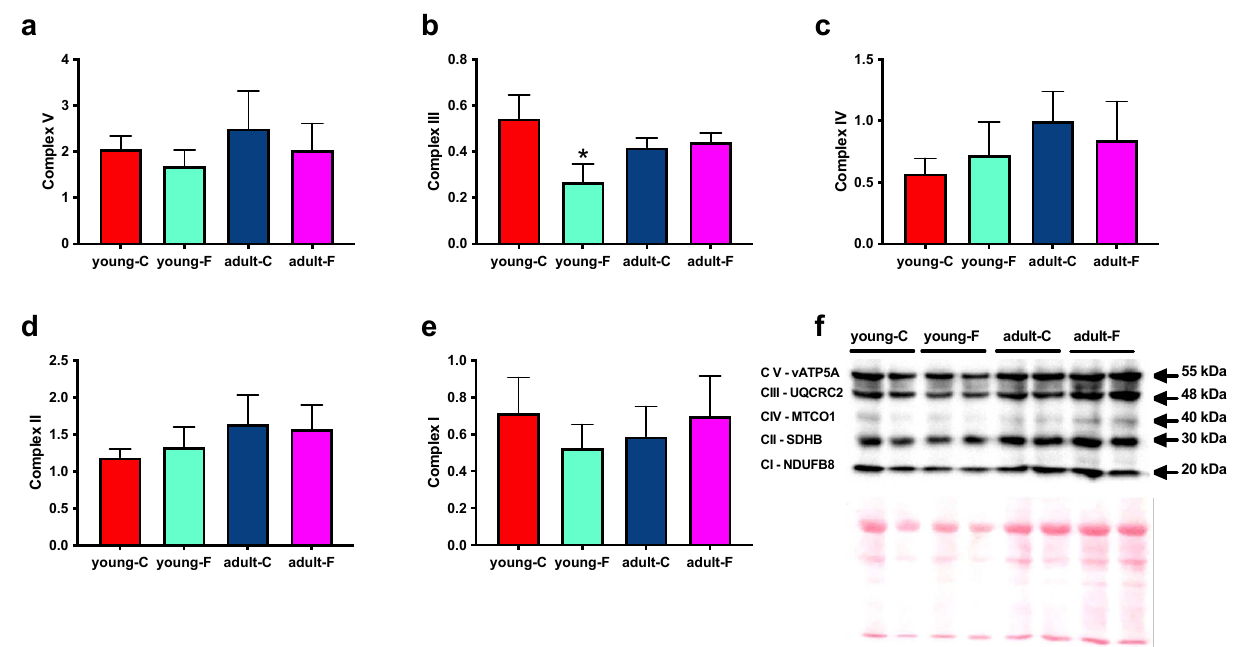
Figure 5. Mitochondrial complexes. ( e ) Complex I, ( d ) complex II, ( b ) complex III, ( c ) complex IV, and ( a ) complex V, together with representative Western blots, which were normalized via Ponceau staining ( f ), assessed in isolated mitochondria from young and adult rats fed a control (young-C and adult-C) or fructose-rich diet (young-F and adult-F) for 2 weeks. Values are the means ± SEM of eight different rats. * p < 0.05 compared to respective controls (two-way ANOVA followed by Tukey post-test).